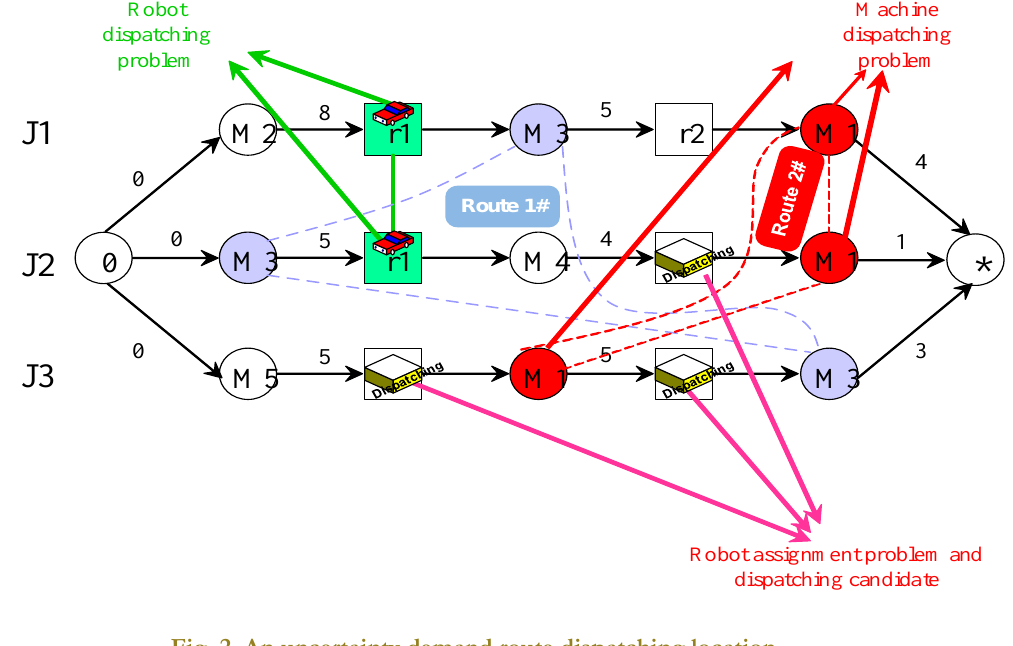
Fig. 2. An uncertainty demand route dispatching location.